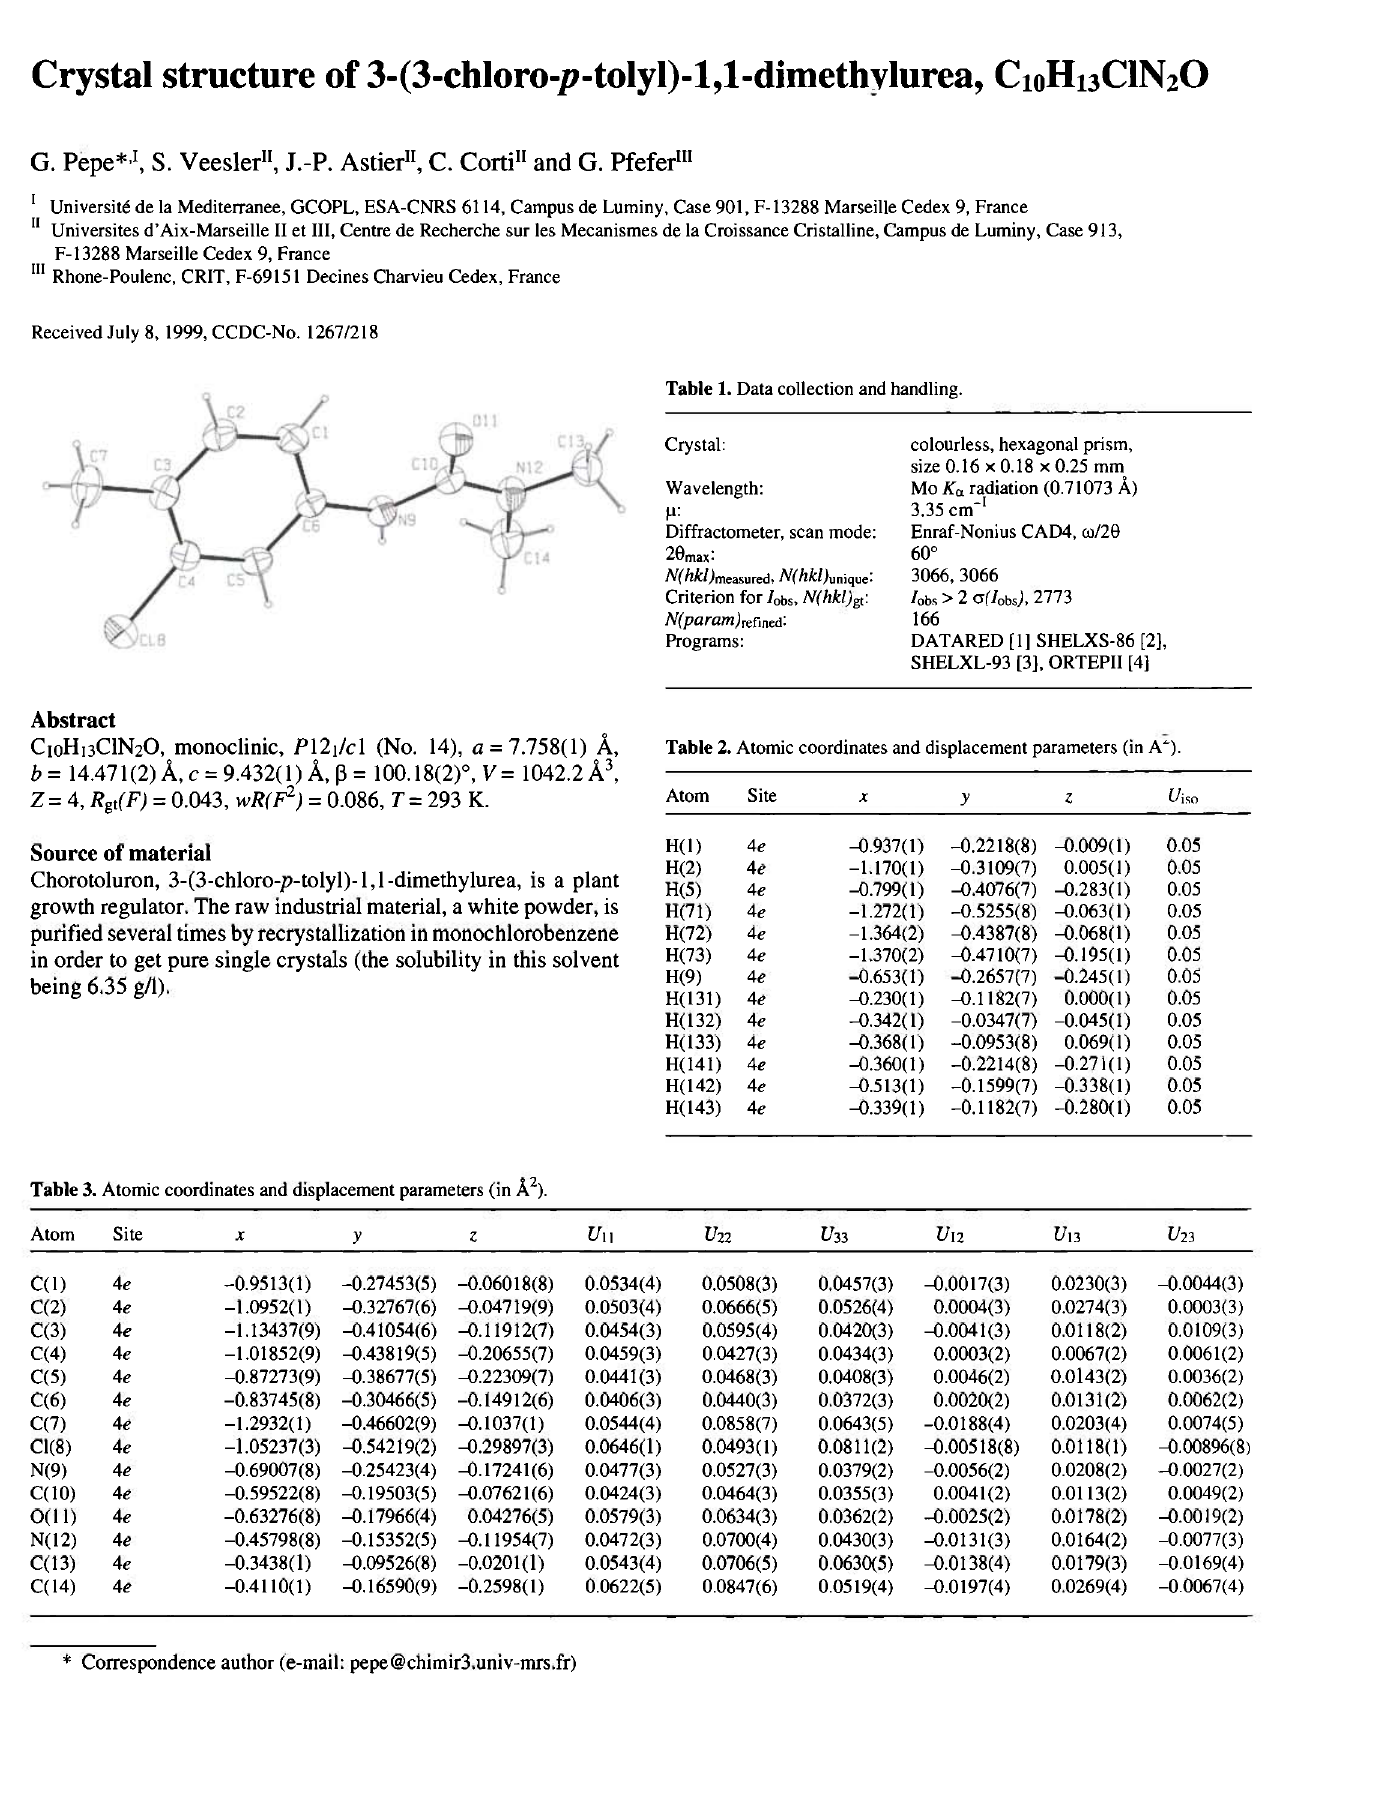
Table 1. Data collection and handling. Crystal: